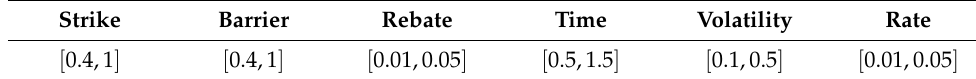
Table 3. Extended Black–Scholes range of parameters—rebate barrier.